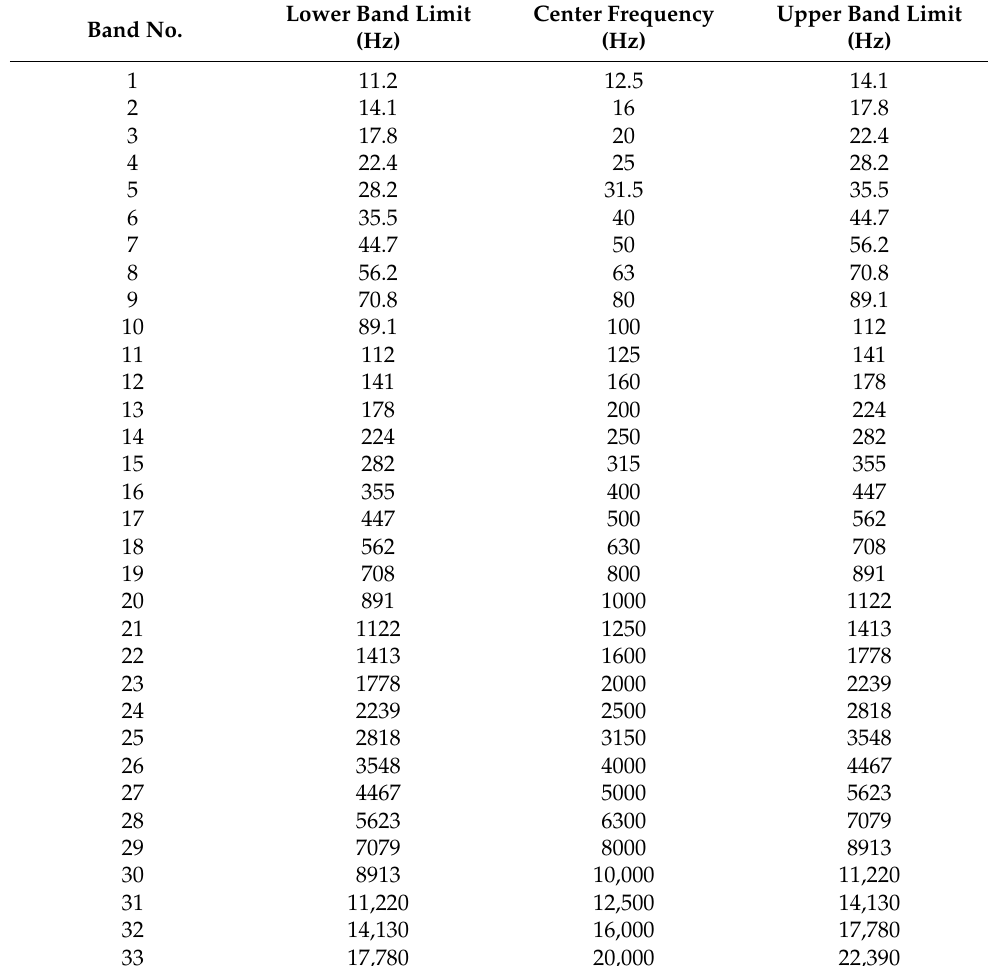
Table A1. Third-octave